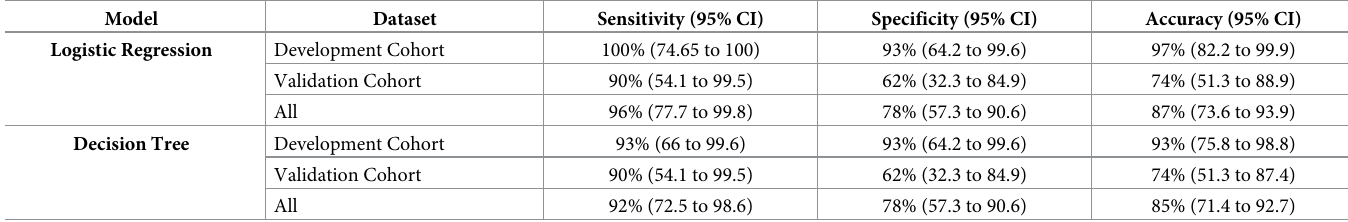
For additional evaluation, the Logistic Regression and the Decision Tree model models were estimated using all 52 participants and the predictions compared with the clinical categoriza- tion. The merged data were 87% consistent with the clinical categorization using the Logistic Table 2. Logistic Regression and Decision Tree Models performance by